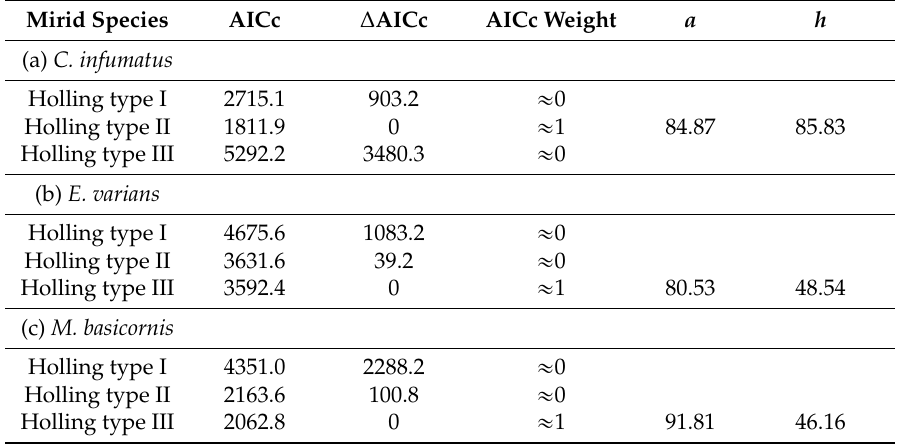
Table 1. Results of the model selection with Akaike’s information criterion and parameters for the best model for each predator